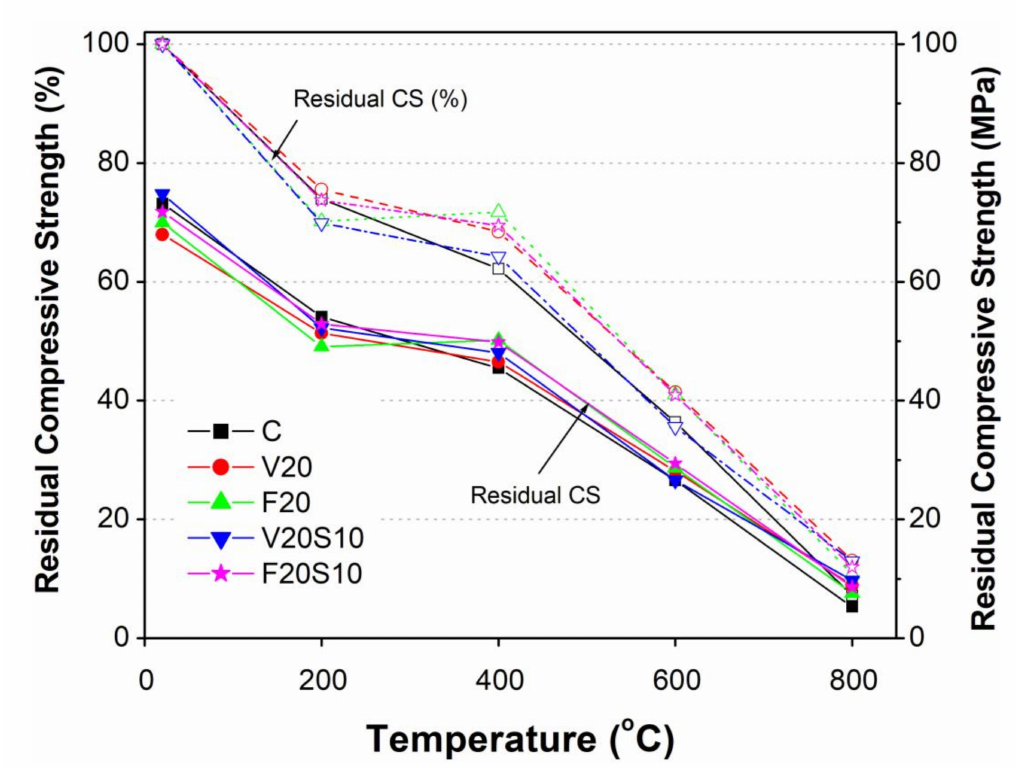
Figure 6. Comparison of residual compressive strength of VA concretes with that of CC and reference FA